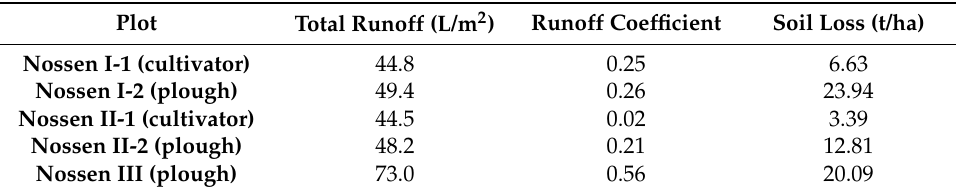
Table 2. The total runoff, runoff coefficient and soil loss per plot.